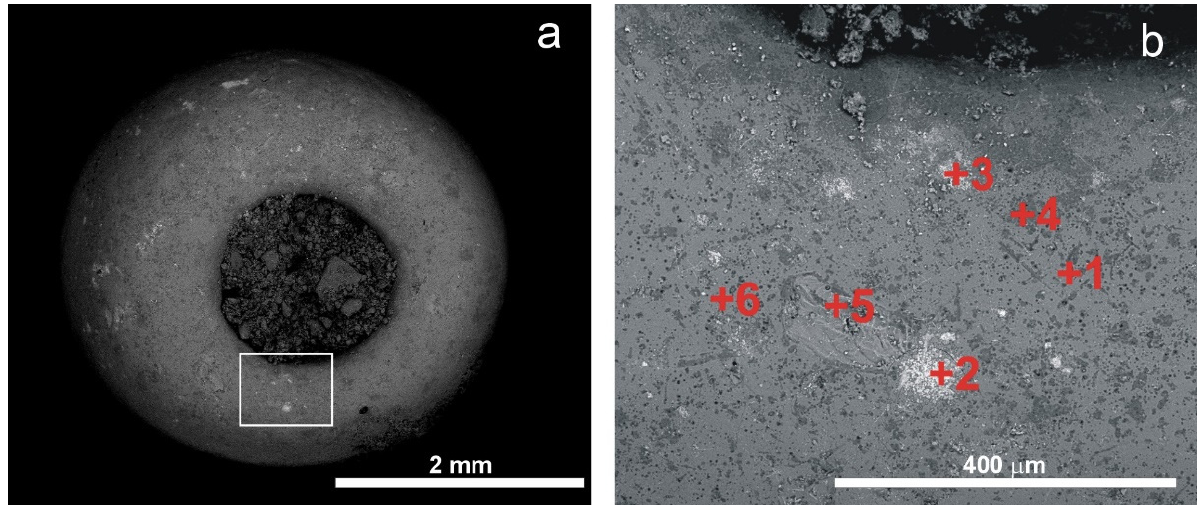
Figure 10. Backscattered electron (BSE) image of the surface of the black bead ( a , b ). For chemical analyses obtained at the points numbered 1–6, see Table 4. Table 4. Chemical composition, in weight percentage, of the black bead. For all elements (except anion Cl), the composition is expressed as oxides weight %. The exact positions of the analysed points are shown in Figure 10.